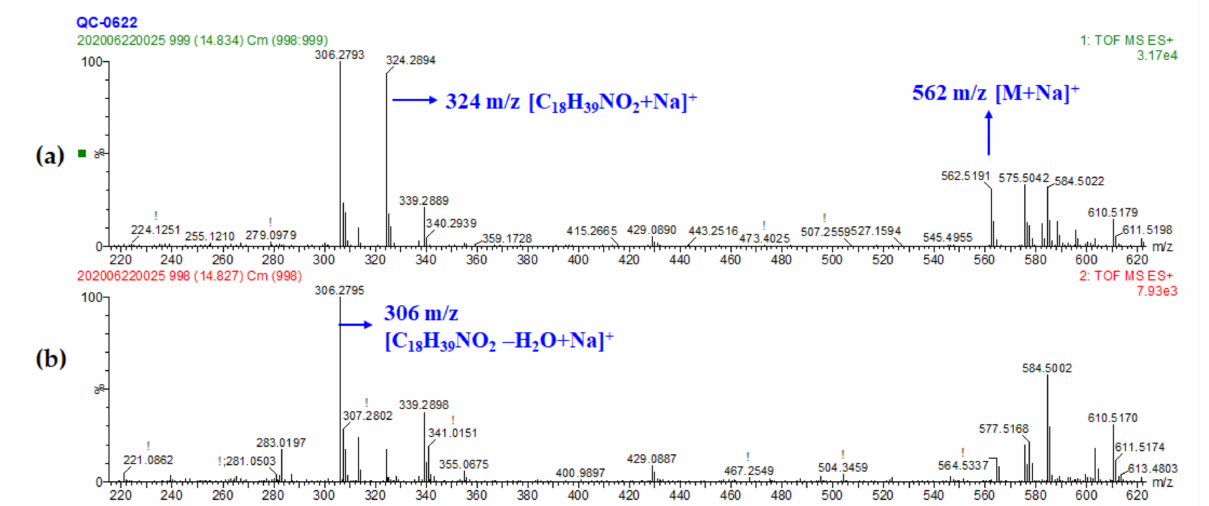
Figure 4. MS spectra of Cer (d18:0/16:0). (peak 30) ( a ) MS 1 spectrum and ( b ) MS 2